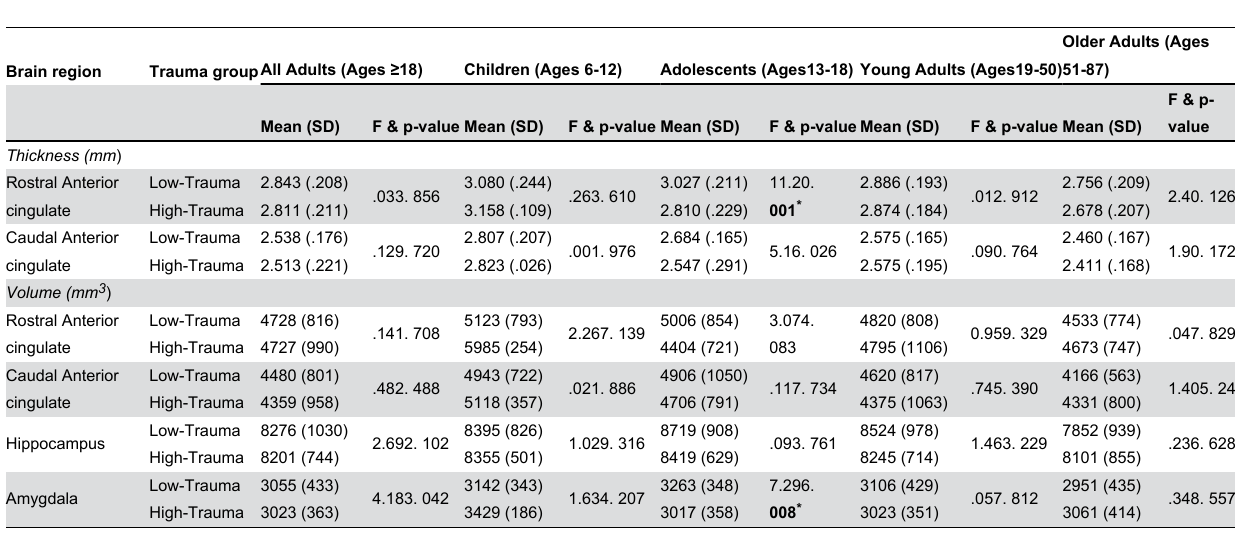
Table 2. Means and statistical values for cortical thickness and volume for the cingulate and limbic regions as a function of early life trauma and age.